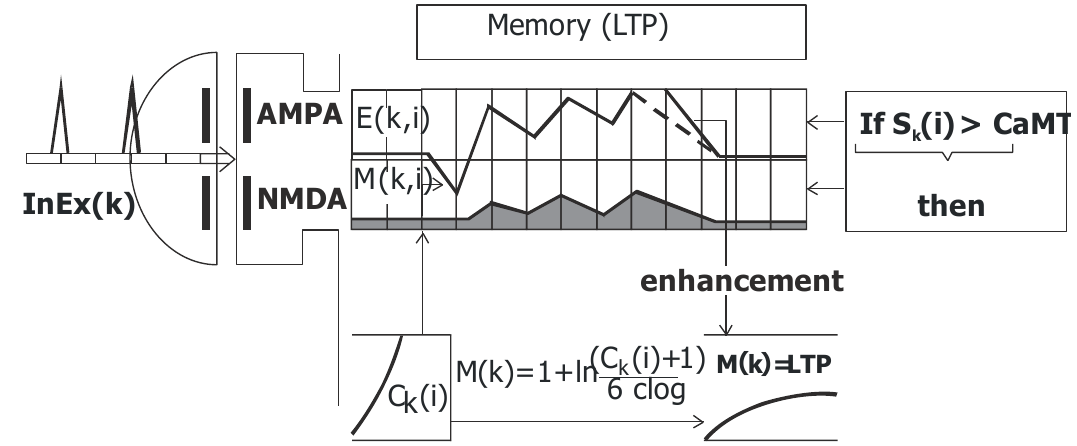
Figure 3. Organization of program functions loops for calculation of the LTP value.